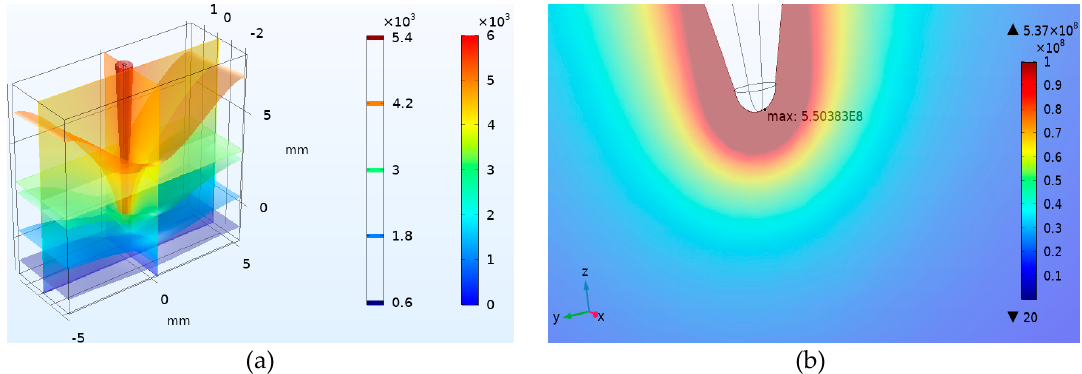
Figure 8. Electric field intensity distribution diagram of the needle-plate electrode. ( a ) Equipotential surface distribution and ( b ) maximum field intensity position.